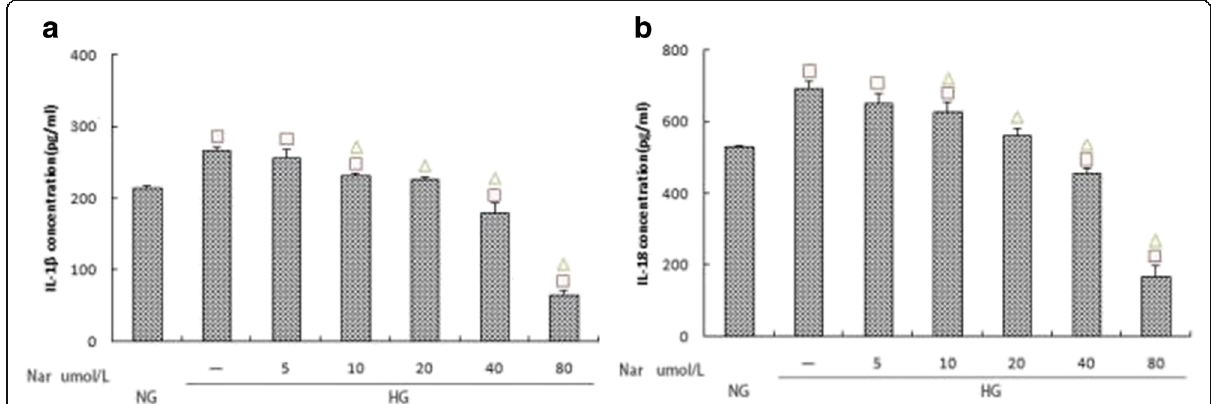
Fig. 9 a , b Effects of different naringin concentrations (0,5,10,20,40 and 80 umol/L) on the expression of IL-1 β and IL-18 within the high glucose group.The protein levels of IL-1 β and IL-18 in culture supernatants were determined by ELISA. NG:normal control group,HG:high glucose group.Data are presented in mean ± SD, □ P < 0. 05 versus normal control group, △ P < 0. 05 versus high glucose group